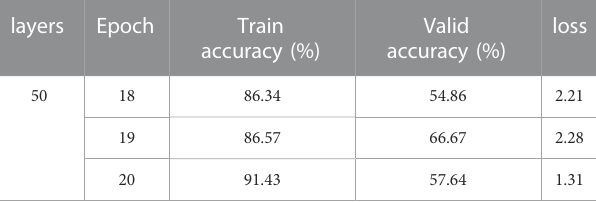
TABLE 4 ResNet50 training accuracy rate and loss change table.